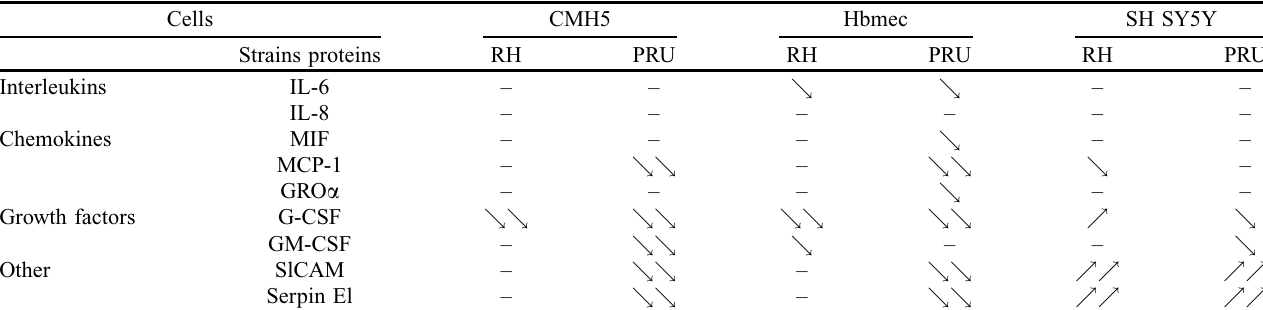
Table 1. Cell types, parasite strains and IFN- c effects on pro-inflammatory protein expressions. Pro-inflammatory proteins were analysed in supernatants of cultivated RH- or PRU-infected cells using Proteome Profiler Array. All spots were quantified as pixel units by GeneTools. Quantification corresponds to the pixel values of uninfected cells (negative control) subtracted from pixel values of infected cells. The effect level was determined using the Scheirer-Ray-Hare test and Steel-Dwass and/or Siegel-Castellan post hoc tests. & expression decrease with p < 0.05; && expression decrease with p < 0.001. % expression increase with p < 0.05; %% expression increase with p <